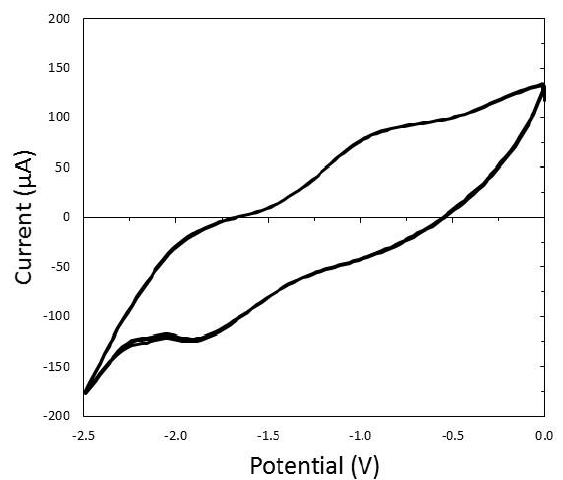
Figure 9. CV anodic sweep of +2Zn2 . Potential vs. (NHE) in dry degassed DMF.